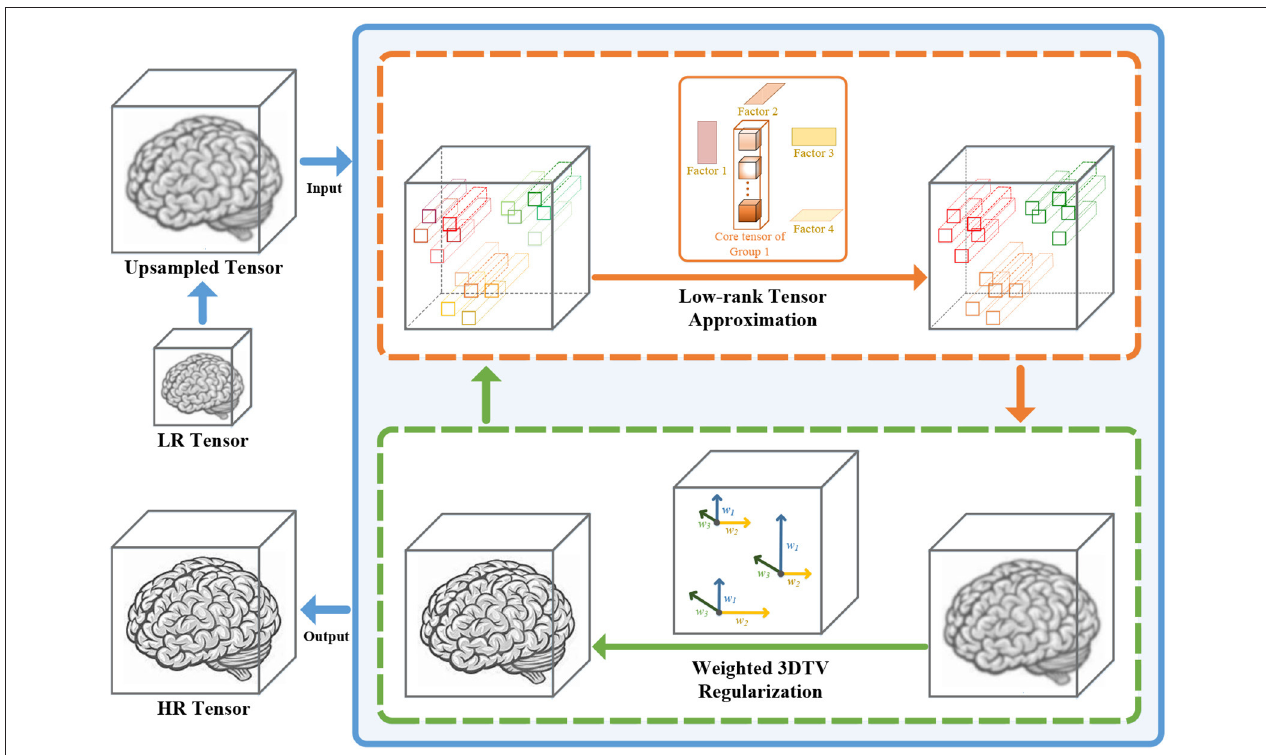
FIGURE 1 | The detailed framework of our method. The proposed method is divided into two parts, the low-rank regularization term, and the 3D total variation (TV) regularization term. The low-rank regularization term (the orange box) reconstructs the main information of the data by performing Tucker decomposition for the nonlocal similar self-similarity patches. The 3D TV regularization term (the green box) uses the local smoothness of the data to suppress the noise and keep the